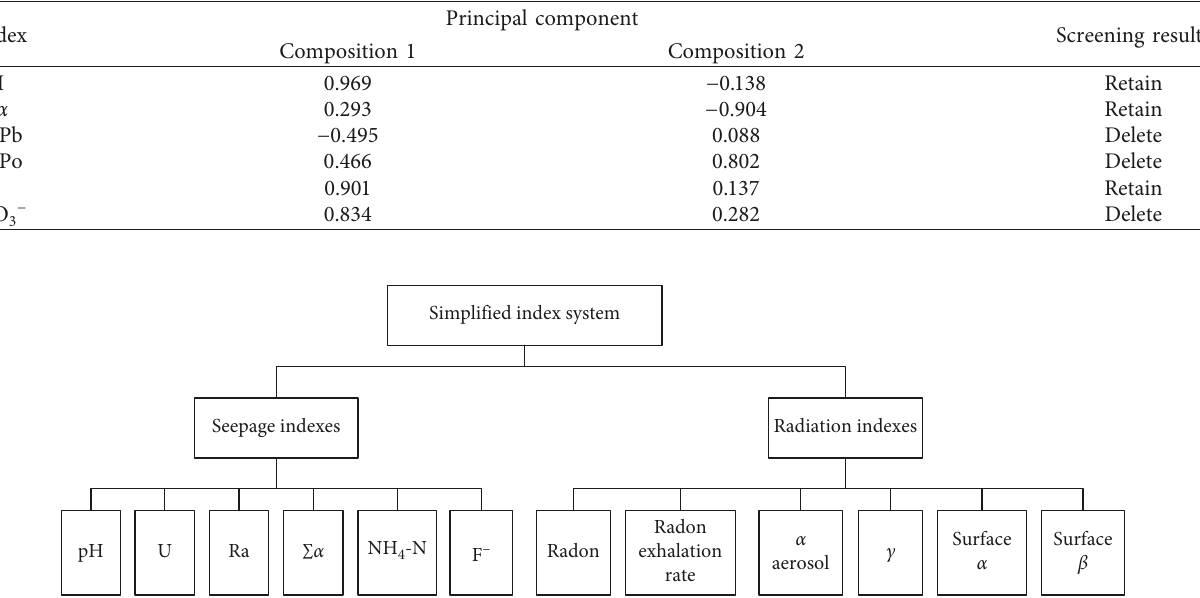
Table 6: The factor loading matrix of the principal component.